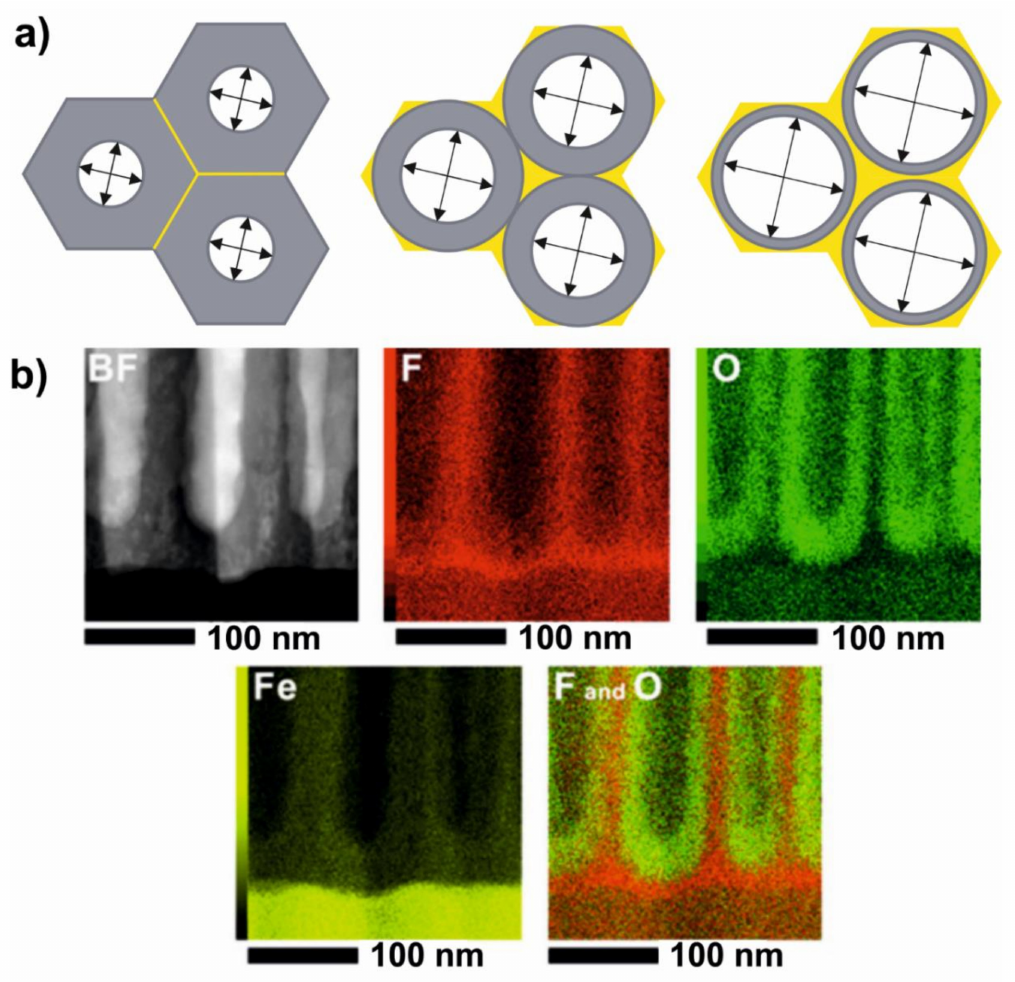
Figure 10. Nanotubes array formation during anodization in fluoride containing electrolyte: ( a ) top view of fluorides distri- bution in tubes array; ( b ) atomic resolution microscopic analysis of fluoride-enriched layer of anodized iron. Reproduced with permission from Ref. [143]. Copyright 2018 John Wiley and